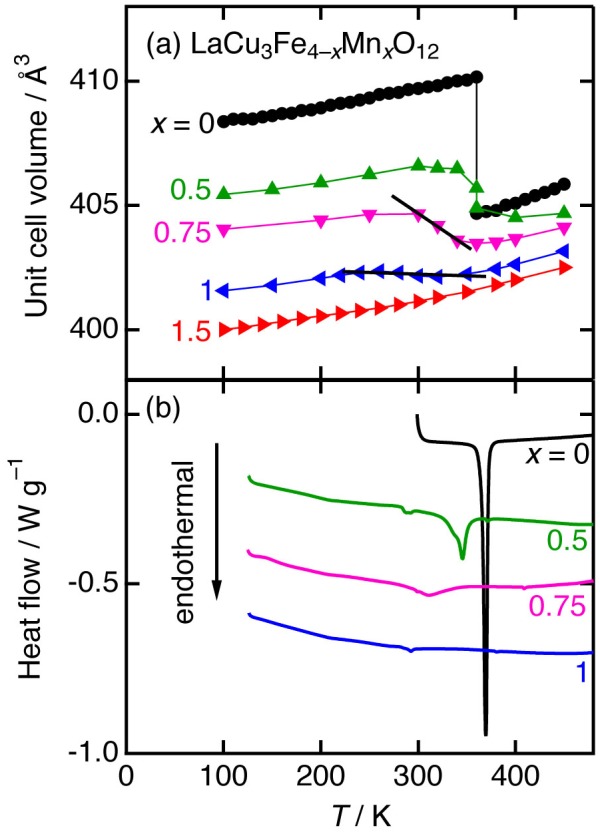
Temperature dependence of the unit cell volume (a) and differential scanning calorimetry curves (b) of LaCu3Fe4–xMnxO12 (x = 0, 0.5, 0.75, 1, and 1.5). Reproduced from [53] with permission from AIP Publishing LLC.